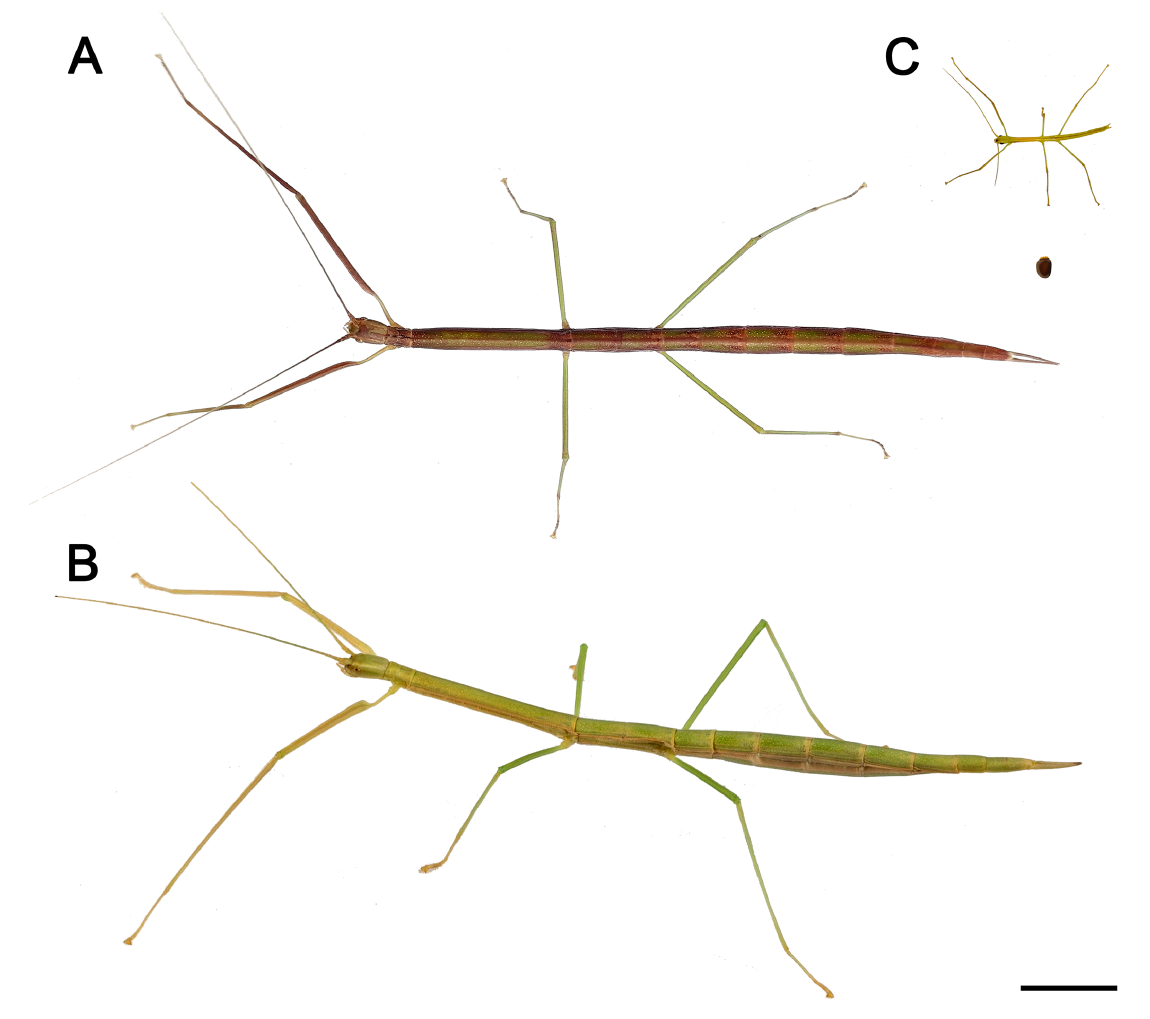
Fig. 1. Live habitus of Arumatia dubia (Caudell, 1904) gen. et comb. nov. A . Adult female (MZUSP V0547) from Araguari, Minas Gerais, Brazil. B . Adult female from Brasília, Distrito Federal, Brazil. C . Egg and first instar female nymph from the female from Brasília. Scale bar: 10